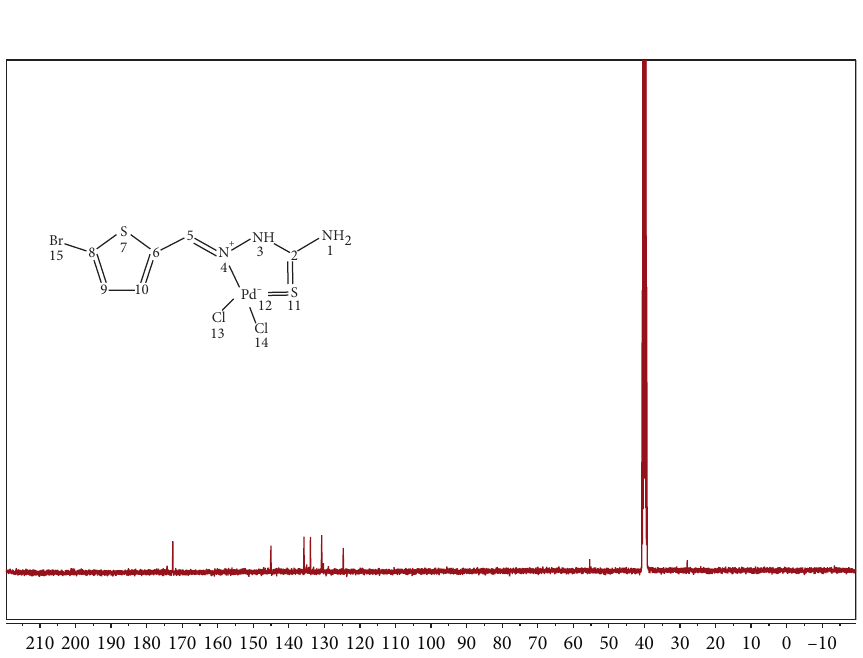
Figure 5: 13 C-NMR for C2 .